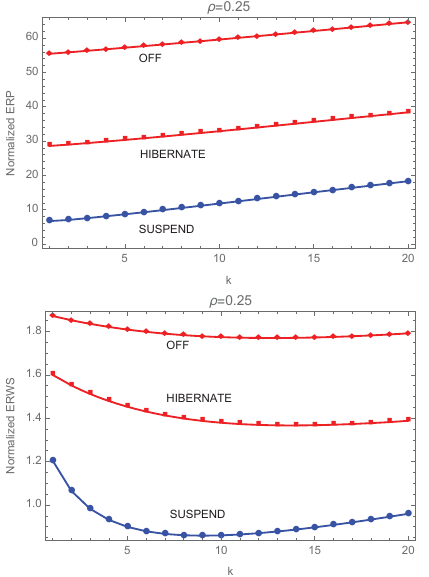
Figure 1: ERP and ERWS of the sleeping policies as a function of the switch-on threshold, normalized with respect to the non energy-aware M/G/ 1 system.